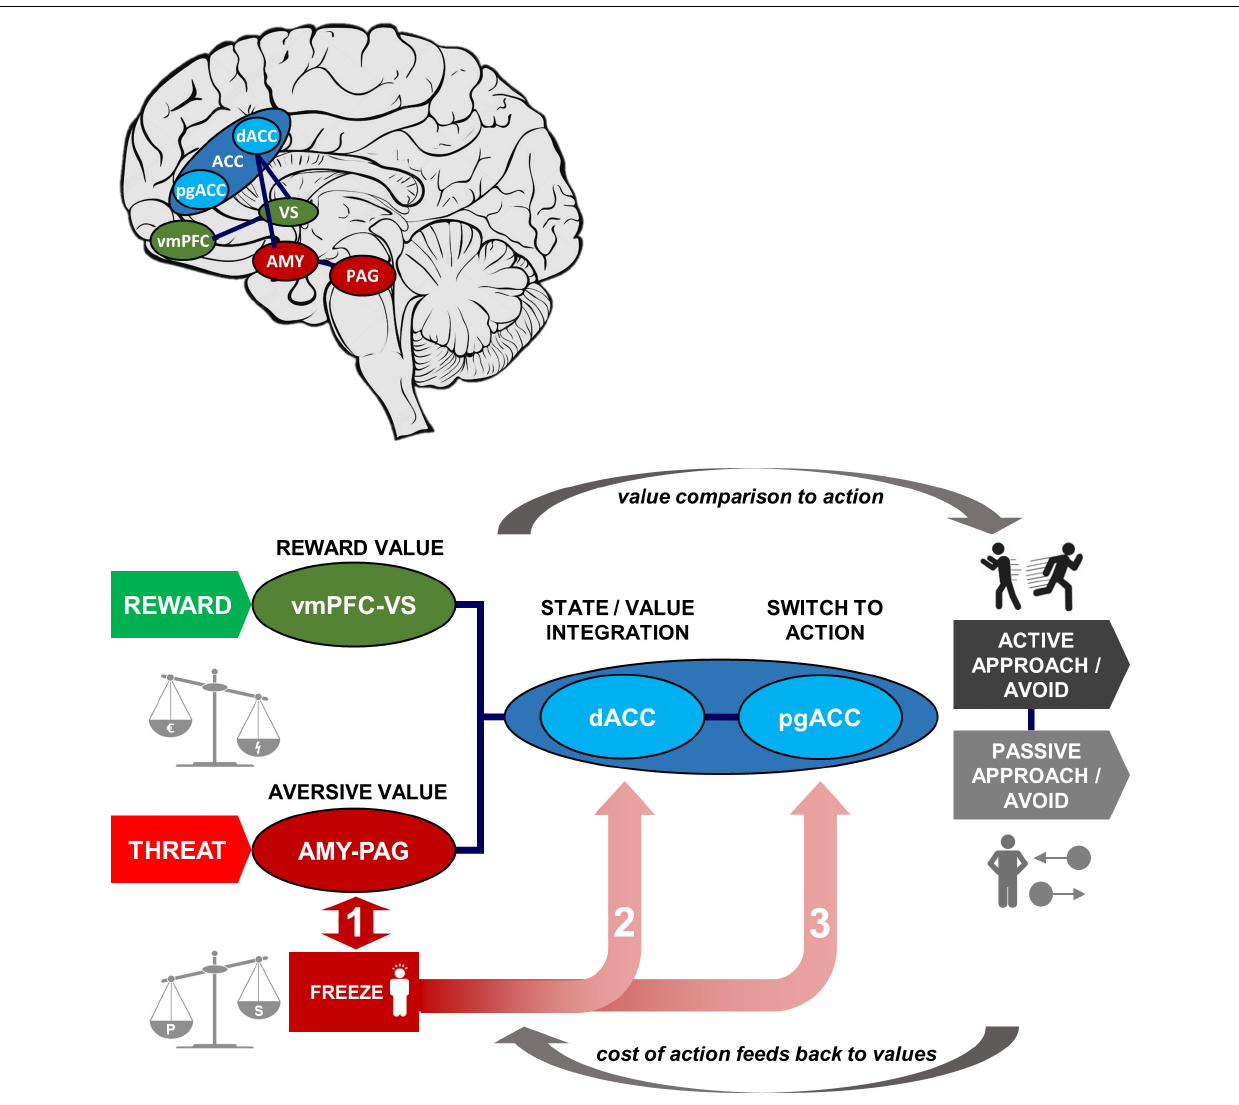
FIGURE 2 | Schematic of Threat State/Value Integration (TSI) Model, with neural structures and functions involved in approach-avoidance action decisions under threat and illustrative map of locations within the brain. In our model approach-avoidance action decisions are determined not only by the predicted reward and aversive values of the action outcome but also by the costs of switching to action. Aversive and reward values are computed in amygdala-periaqueductal gray and ventromedial prefrontal cortex-ventral striatum subsystems, respectively (left of schematic), then compared in the anterior cingulate to output to action behavior (right of schematic; via sensorimotor regions, not shown). The degree of freezing is measured by the level of immobility and bradycardia, which are the result of the balance in sympathetic and parasympathetic activation. The degree of freezing may impact approach-avoidance action decisions at three possible stages (numbered in the figure): (1) altered aversive value assessment in threat-related pathways; (2) altered integration of values within the dorsal anterior cingulate; (3) altered cost of switching between parasympathetically dominated freezing and sympathetically dominated action in perigenual anterior cingulate cortex (pgACC). The circular arrows show the forward process of value comparison generating action, and the reverse process whereby action costs may retroactively affect value computations via a feedback loop. AMY, amygdala; PAG, periaqueductal gray; (d/pg)ACC, (dorsal/perigenual) anterior cingulate cortex; vmPFC, ventromedial prefrontal cortex; VS, ventral striatum. Green denotes reward and reward-related areas, red denotes threat and threat-related areas, and blue denotes areas of value integration and post-integration action switching.